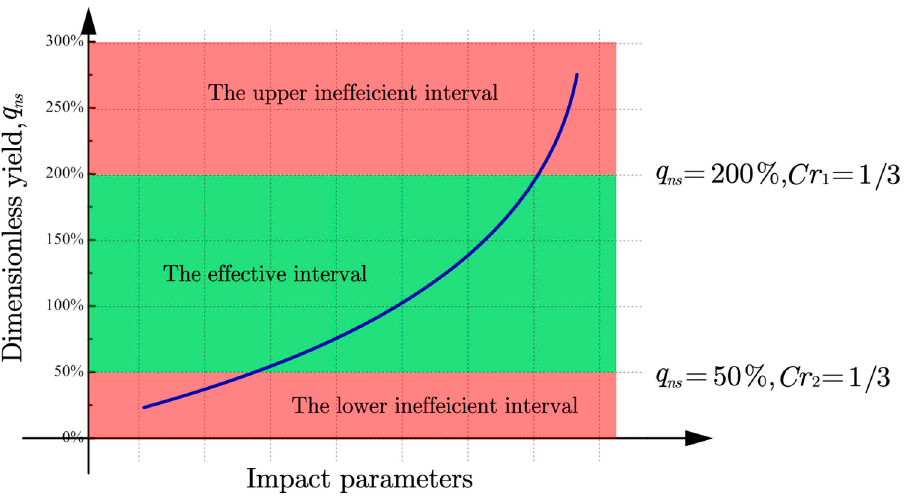
Figure 11. Matching degree curve and three intervals.